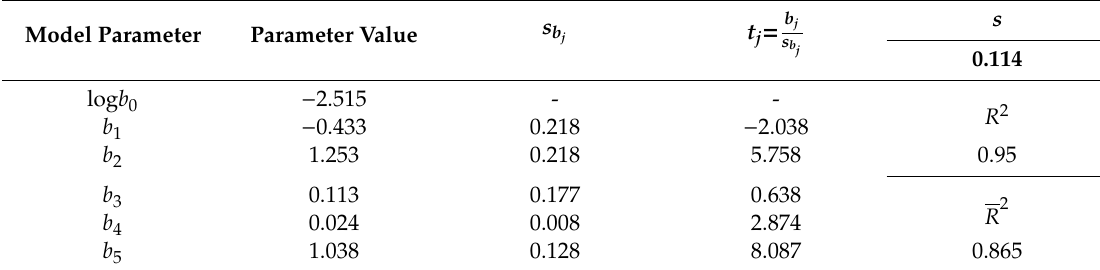
Table 9. The parameters of the transformed regression model with a torque for TD drilling with CB in test tube hardness 28 HRC.